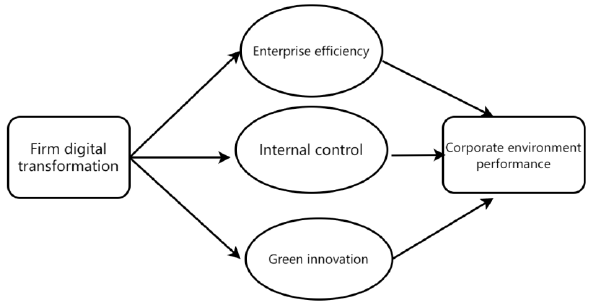
Figure 1. The relationship between digital transformation and corporate environment performance.